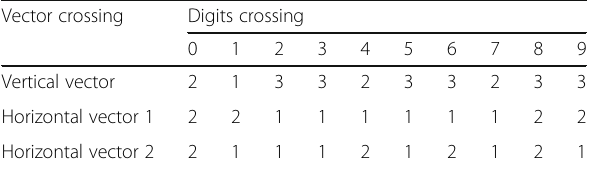
Table 1 Vector crossing using three vectors